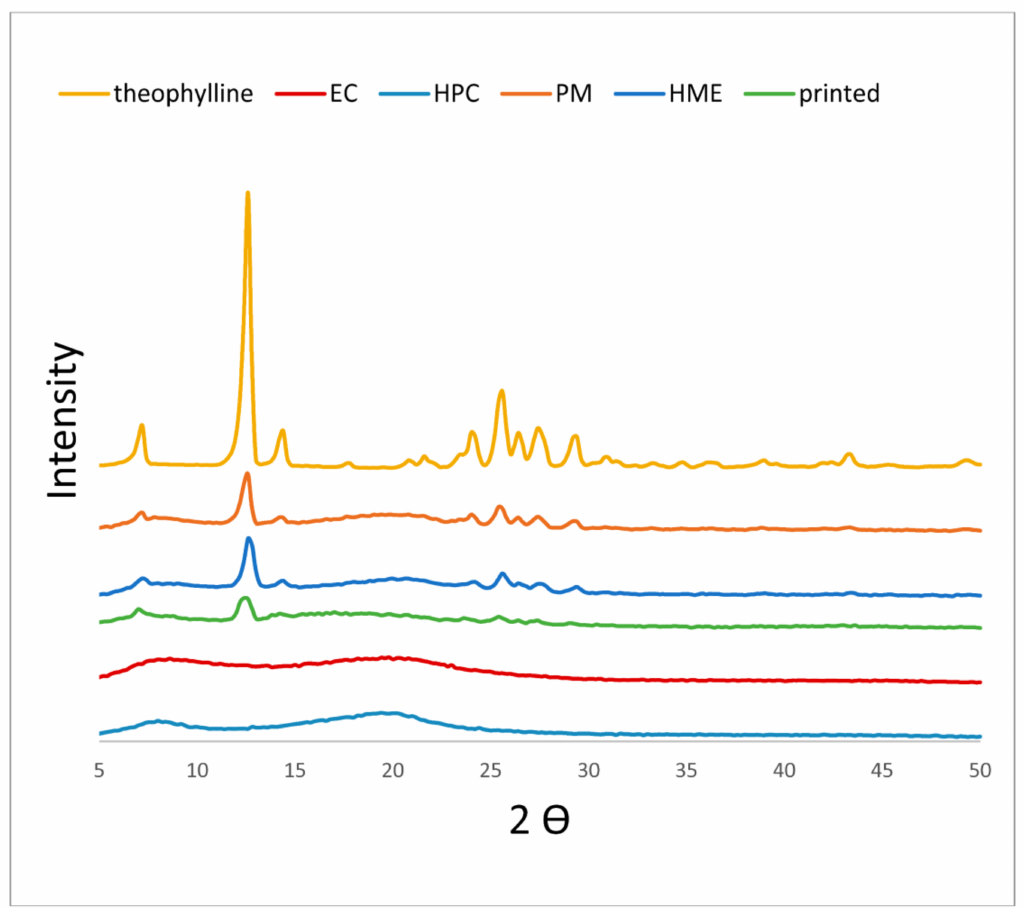
Figure 3. XRPD diffractograms of F2 tablets and raw